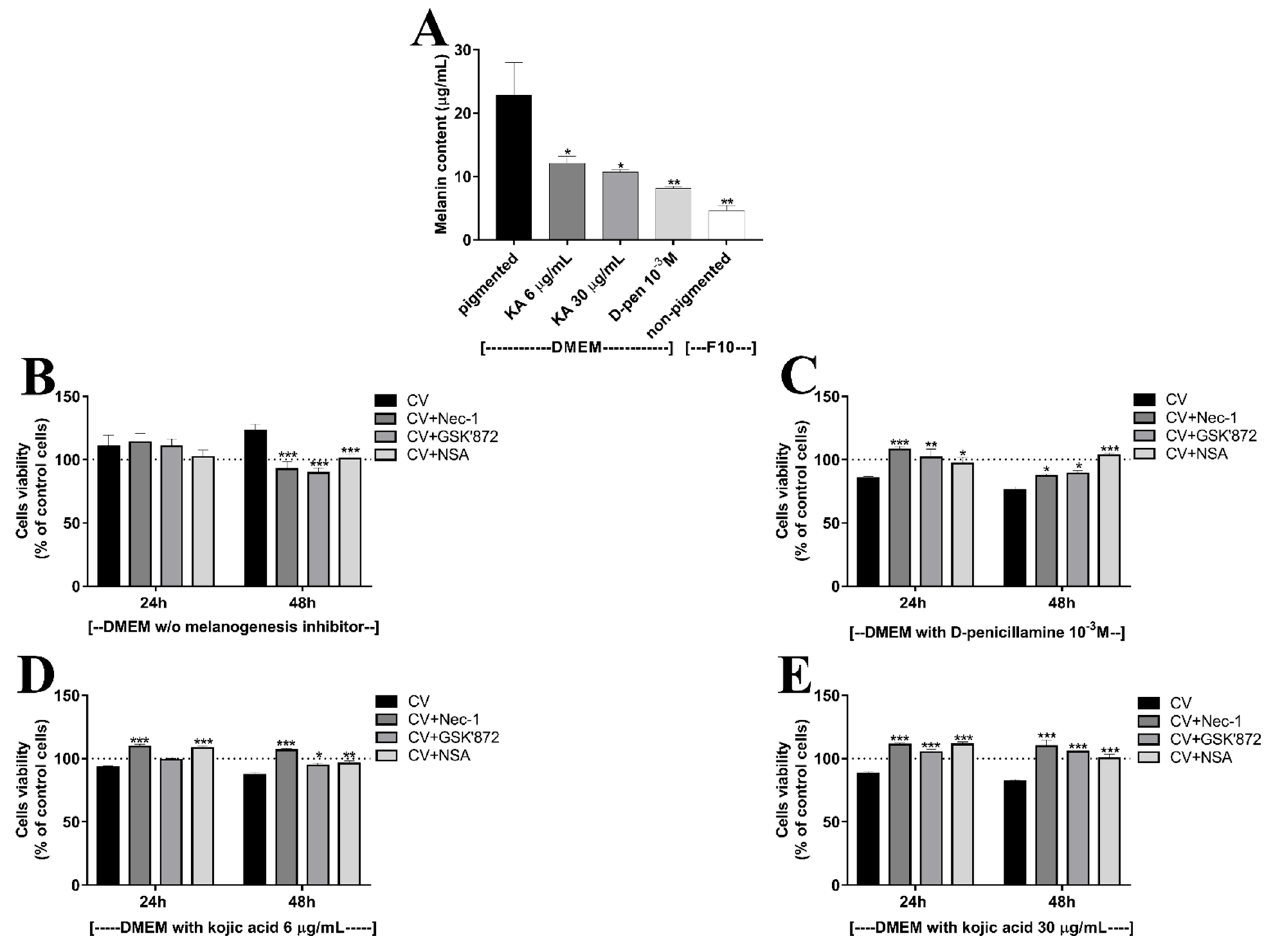
Figure 3. The inhibition of RIPK1, RIPK3, and MLKL abolishes the Coriolus versicolor (CV)-mediated cytotoxicity directed towards melanoma cells with inhibited melanogenesis; ( A ) the melanin content in SKMel-188 melanoma cells treated with D -pen or KA at indicated concentrations. Asterisks indicate significant differences between pigmented cells and depigmented/non-pigmented ones (* p < 0.05, ** p < 0.01); ( B ) the viability of pigmented melanoma cells treated with CV extract at a concentration of 200 µ g/mL or co-treated with CV and Nec-1 (30 µ M), GSK’872 (10 µ M) or NSA (1.5 µ M) for 24 and 48 h; ( C – E ) the viability of pigmented melanoma cells exposed to 10 − 3 M D -pen ( C ), 6 µ g/mL KA ( D ) or 30 µ g/mL KA ( E ) treated with CV at a concentration of 200 µ g/mL or co-treated with CV and Nec-1 (30 µ M), GSK’872 (10 µ M) or NSA (1.5 µ M) for 24 and 48 h. Data are reported as means ± SEM of three independent experiments, with six wells in each experiment. Asterisks indicate significant differences between CV-treated cells and cells co-treated with CV and necroptosis kinases inhibitors (* p < 0.05, ** p < 0.01, *** p < 0.001). Abbreviations: PBS—phosphate-buffered saline; CV— Coriolus versicolor extract; D -pen— D -penicillamine 10 − 3 M; KA—Kojic acid 6 or 30 µ g/mL; RIPK1 - receptor interacting protein kinase 1; RIPK3 - receptor interacting protein kinase 3; MLKL - mixed lineage kinase domain-like protein; Nec-1—necrostatin-1; NSA—necrosulfonamide.